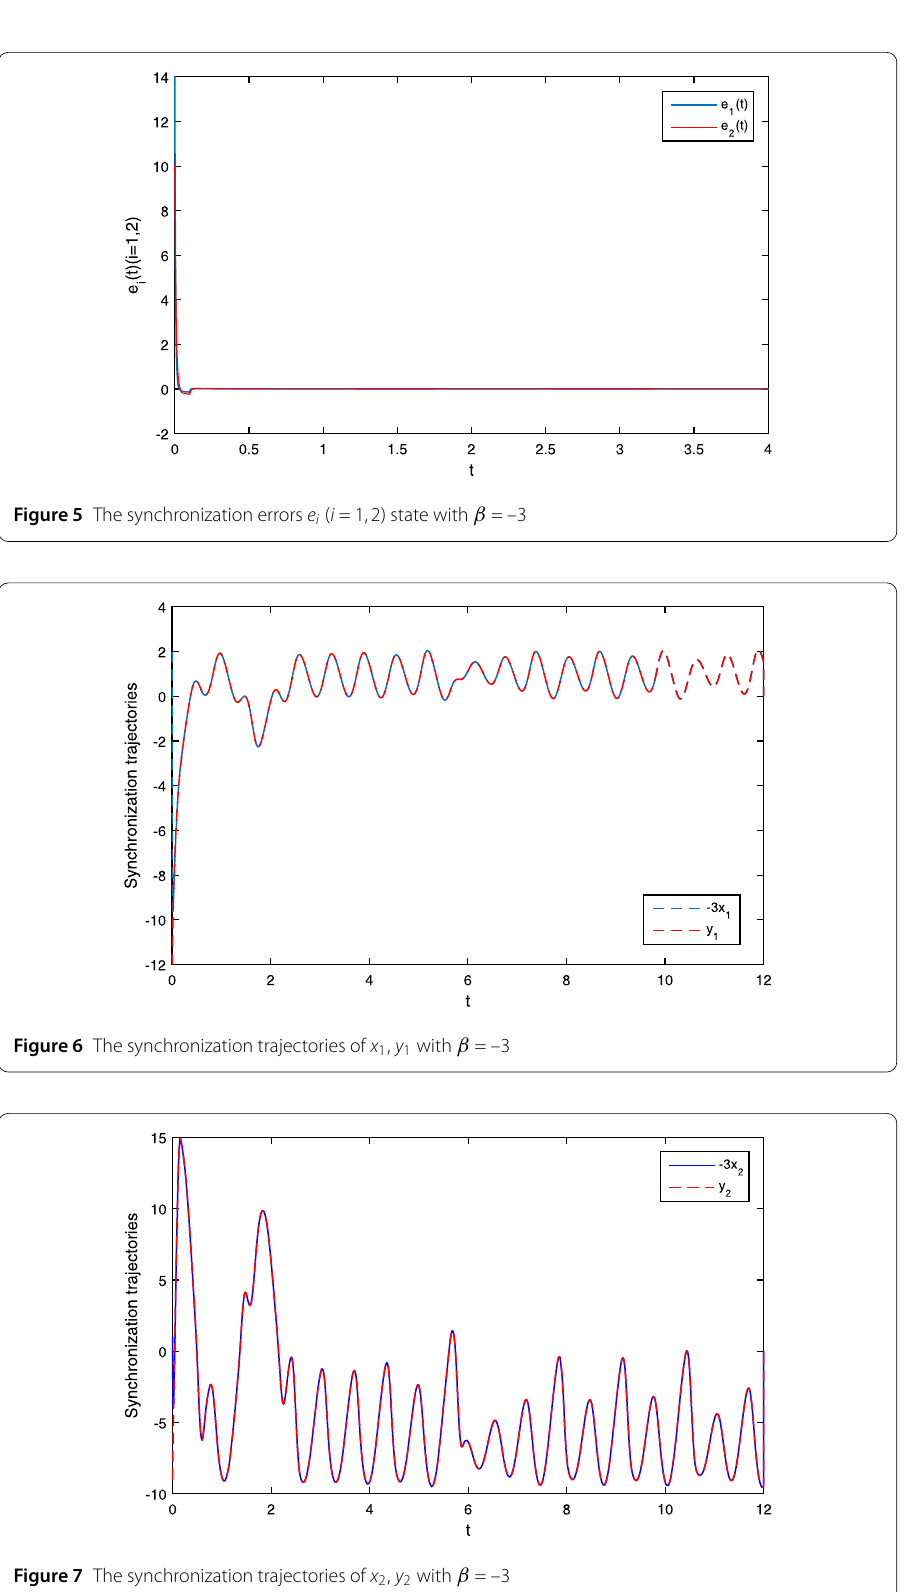
Figure 7 The synchronization trajectories of x 2 , y 2 with β =